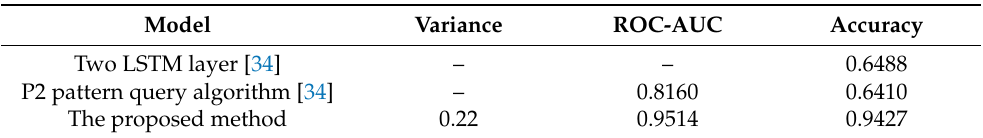
Table 8. Comparison between the proposed method and previous research for music genre